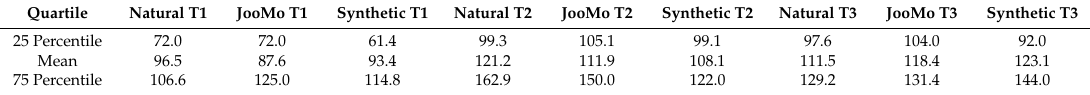
Figure 2. Richness of the different time points per group. This figure shows a significant increase of richness. The samples were normalised to a read depth of 534 sequences. Table 1. Numerical values of diversity for Figure 1 box